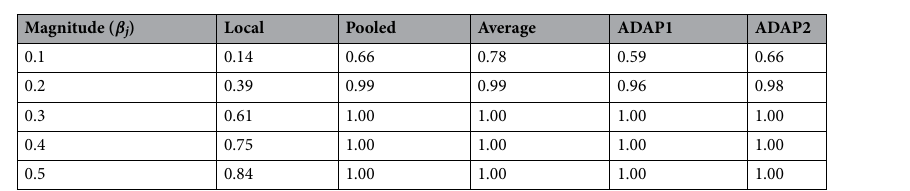
Table 1. True positive rates. The true positive rate is calculated as the percentage (over 400 replications) of coefficients that are estimated to be nonzero among nonzero coefficients in the true coefficient vector.